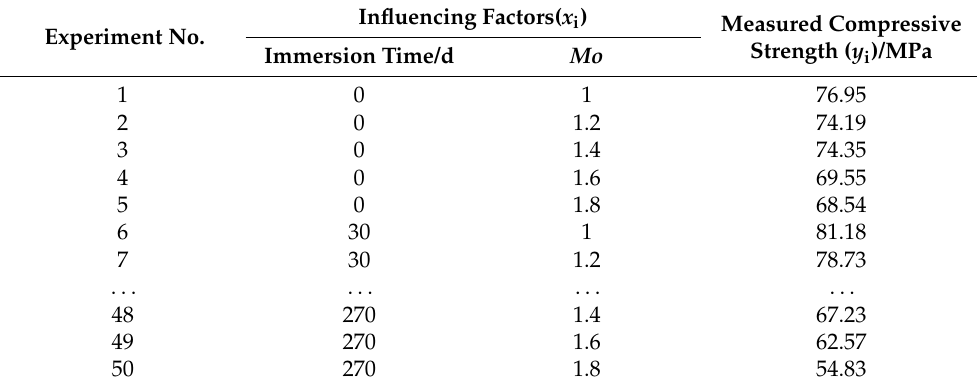
Table 7. Data for sample